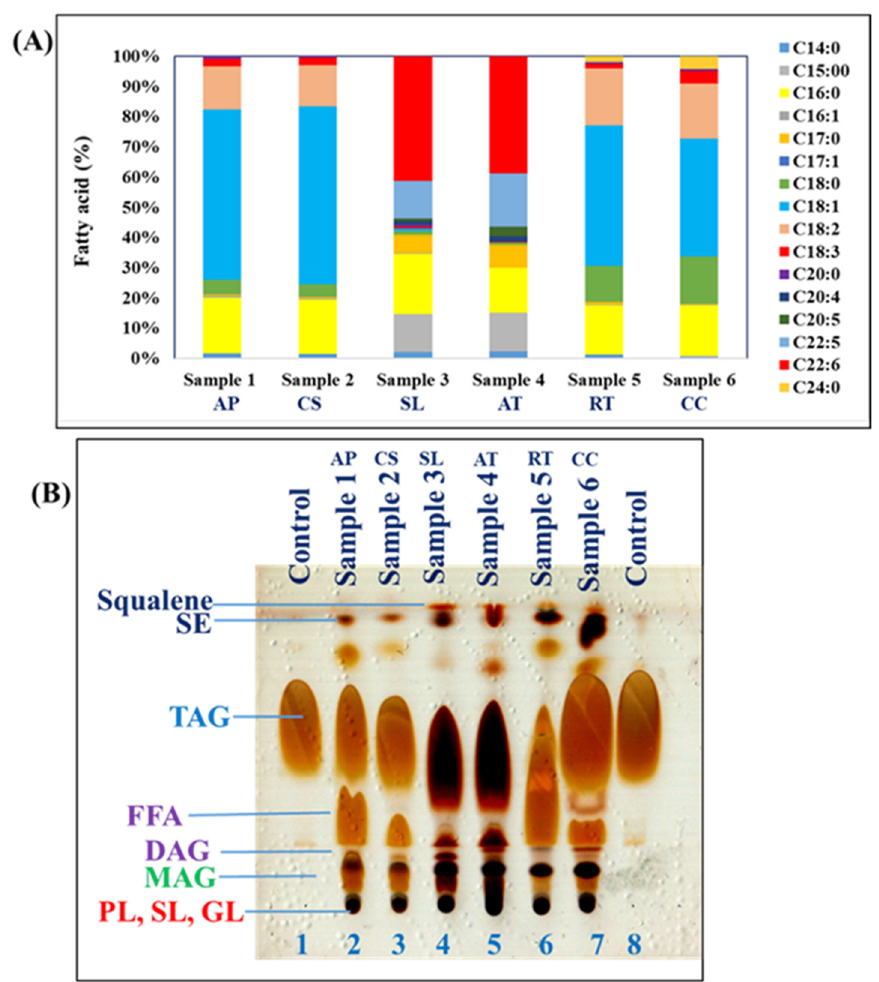
Figure 2. ( A ) Lipid profile of oils extracted from various oleaginous microorganisms such as A. pro- tothecoides (AP) and C. sorokiniana (CS); thraustochytrids S. limacinum (SL) and Aurantiochytrium sp. T66 (AT); and yeasts R. toruloides (RT) and C. curvatus (CC). ( B ). Estimation of total lipids by TLC. Lane 1, TAG standard; lanes 2 and 3, microalgal lipids; lanes 4 and 5, thraustochytrid lipids; lanes 6 and 7, yeast lipids; lane 8, TAG